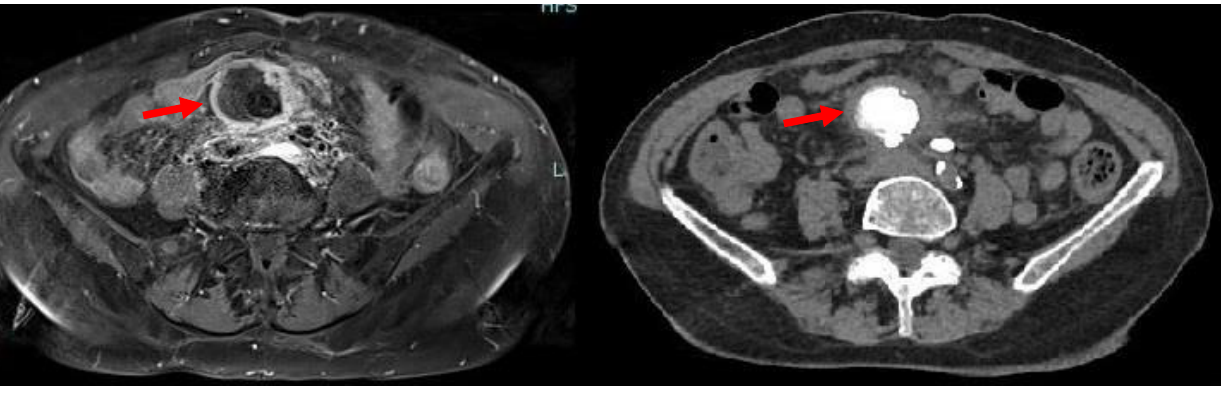
Figure 1. Axial MRI ( left ) and CT ( right ) scan showing the presence, in mesogastrium, of a nodular mass (red arrows) with contrast enhancement at MRI and internal calcifications at CT.